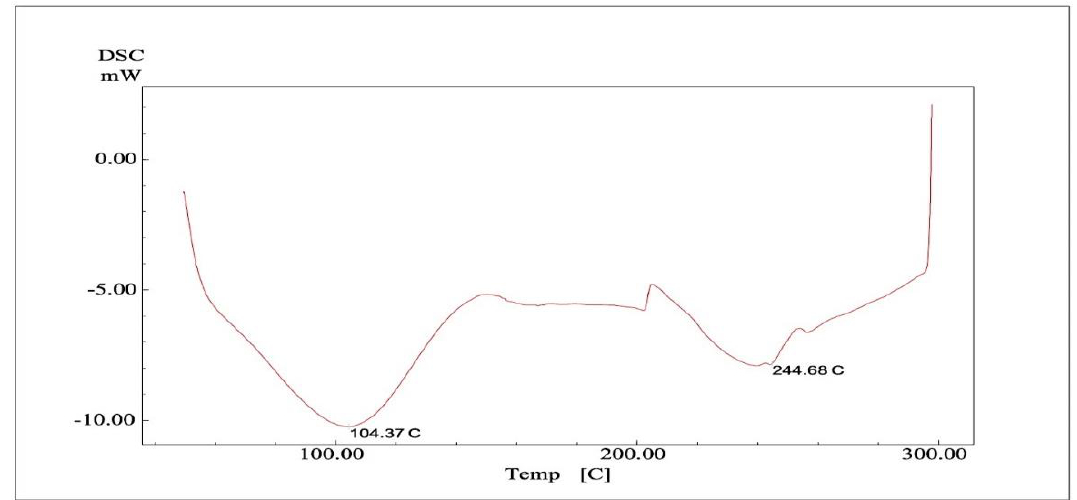
Figure 18. DSC thermogram of physical mixture of PVP-K15:pure domperidone (2:1)